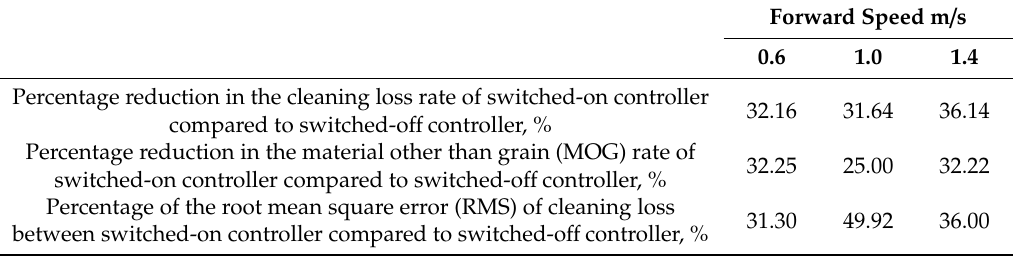
Table 7. Comparison of cleaning parameters between controllers switched on and o ff